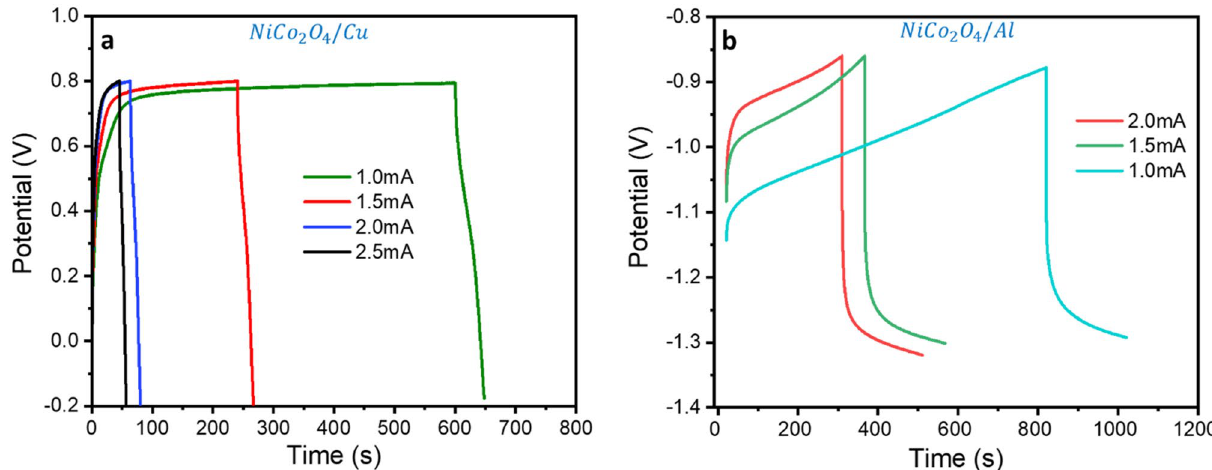
O /Cu and b NiCo O /Al supercapacitors at different applied current in 1 M of KOH 2 4 2 4